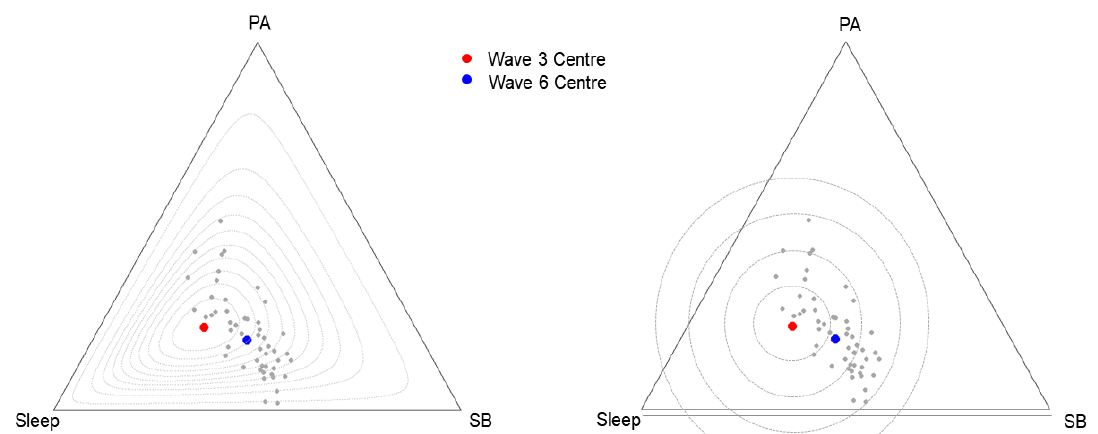
Figure 2. Evenly spaced distance contours around the center of the Longitudinal Study of Australian Children Wave 3 birth cohort time-use compositions (red). The left panel shows contours defined by relative (Aitchison) distance; the right panel shows contours defined by absolute distance (Euclidean). The center of Wave 6 time-use composition is shown in blue. Grey dots represent data from 50 randomly sampled Wave 6 participants. PA = physical activity; SB = sedentary behavior.